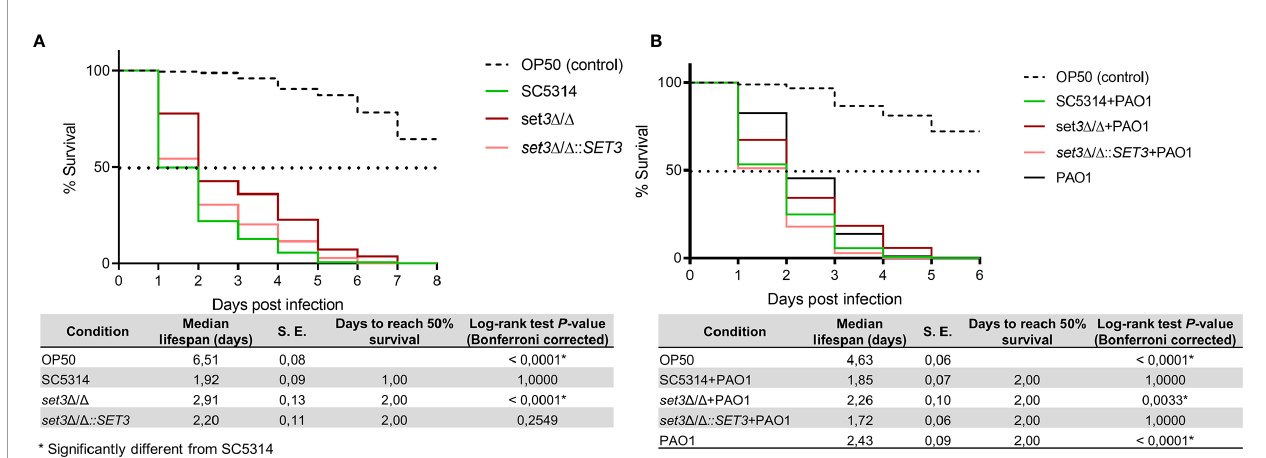
FIGURE 3 | Survival of Caenorhabditis elegans infected with Candida albicans mutants and Pseudomonas aeruginosa . (A) - Percentage survival of C. elegans infected with C. albicans wild type (SC5314) or the homozygous mutant of SET3 ( set3 D / D ) as well as the homozygous mutant with add-back of the wild-type gene ( set3 D / D ::SET3 ). (B) – Percentage survival of C. elegans co-infected with C. albicans mutants and P. aeruginosa (PAO1). Controls consists of C. elegans allowed to feed on Escherichia coli OP50 (OP50). The tables represent median lifespan with standard error (S. E.) along with days to reach 50% mortality. P -values are included for the Log-rank test for overall differences in survival. *Signi fi cantly different from wild type C. albicans